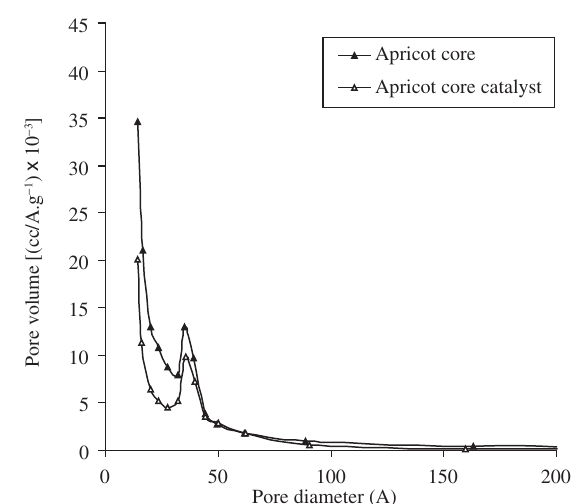
Figure 3. Pore size distribution for apricot core AC support and catalyst.